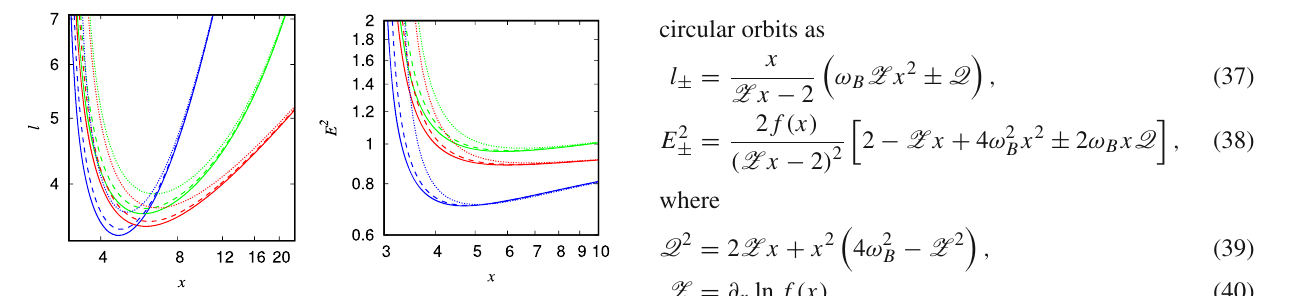
green curve and there is ISCO in the red curve. Only in the blue curve, there exists stable and unstable circular orbits corresponding to the maximum and the minimum of V eff .